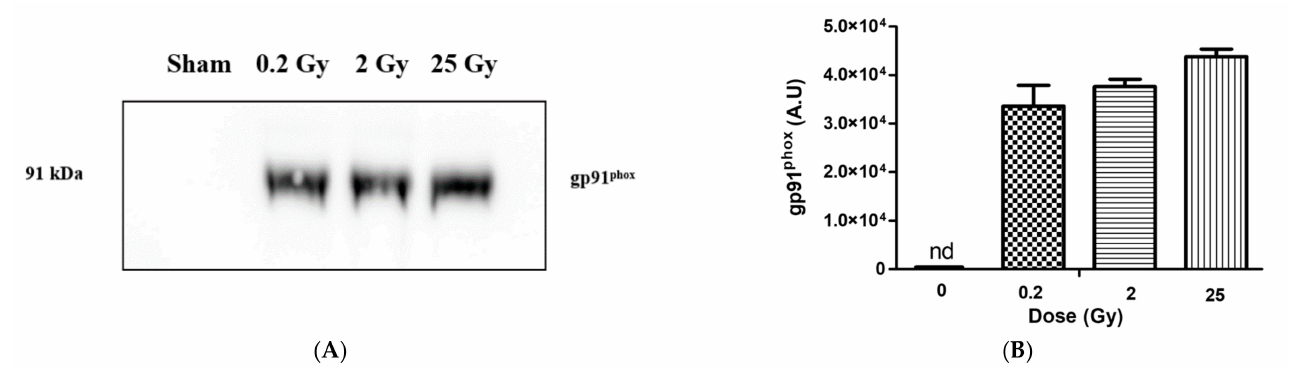
Figure 4. Presence of gp91phox in membrane fractions from irradiated and non-irradiated PLB cells. ( A ) Western blot of membrane fractions (gp91 phox ). Lane 1: 0 Gy (non-irradiated PLB-cells), lane 2, 3 and 4 represent PLB cells irradiated at 0.2 Gy, 2 Gy and 25 Gy, respectively. In each lane, 20 µ g of total membrane proteins (determined from BCA assay) was deposited. The membrane fractions were heated for 5 min at 85 ◦ C, and subject to 10% SDS-PAGE and immunoblotting. Each membrane was incubated with a primary antibody (dilution 1:1500 for gp91 phox ). ( B ) Band intensity of gp91 phox quantified by densitometry using ImageJ software (Java 1.8.0). nd represent non-determined. The Figure is a representation of 2 independent preparations.